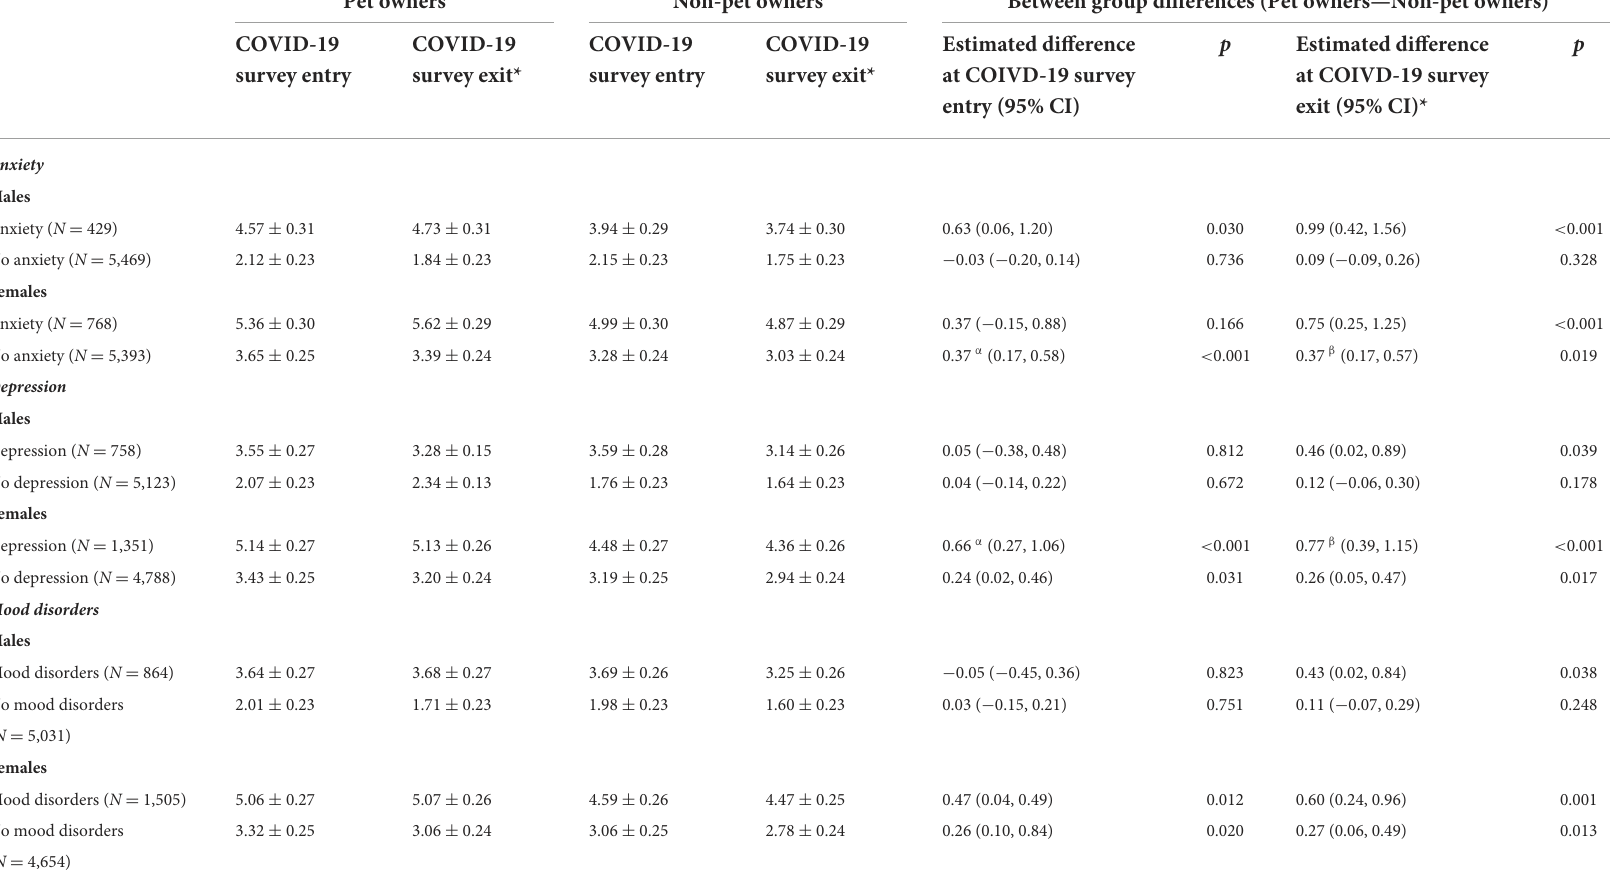
TABLE 9 Estimated marginal means and standard errors for sex differences in General Anxiety Disorder Questionnaire (GAD-7) score at COVID-19 Survey entry and exit, based on mental health disorder status and pet